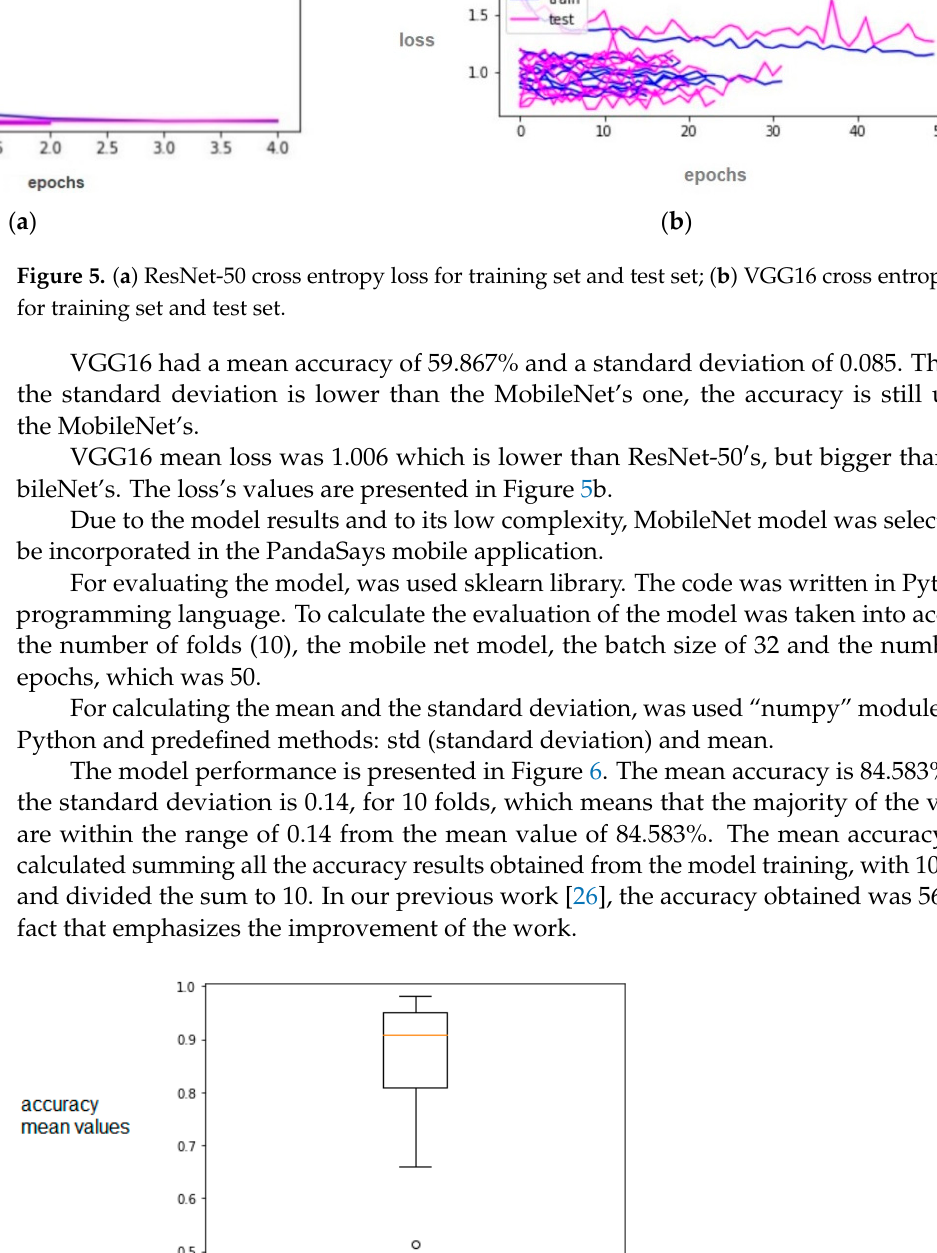
7 of 19 Figure 4. MobileNet model accuracy.